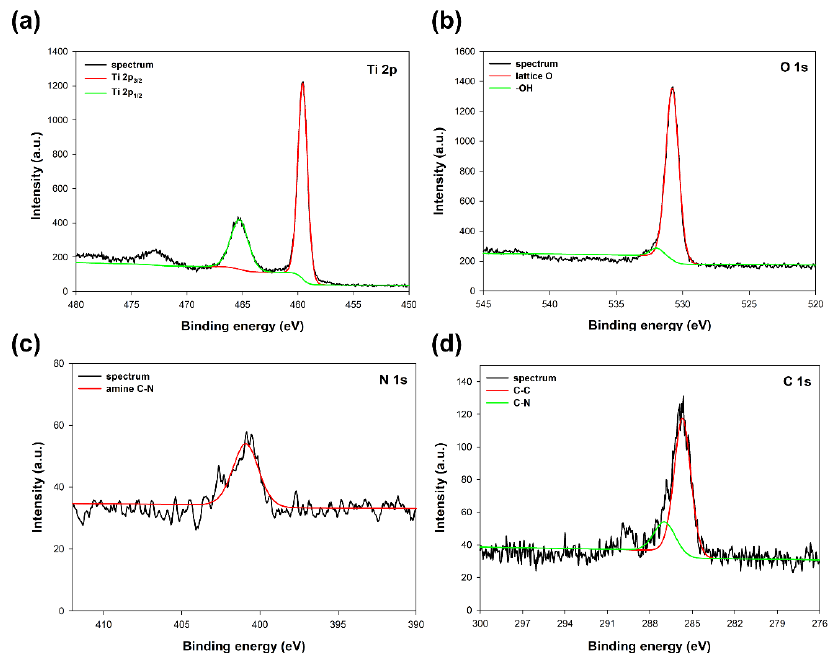
Figure 2. XPS spectra of specific regions: ( a ) Ti 2p, ( b ) O 1s, ( c ) N 1s, and ( d ) C 1s for TiO 2 modified with triethylamine.